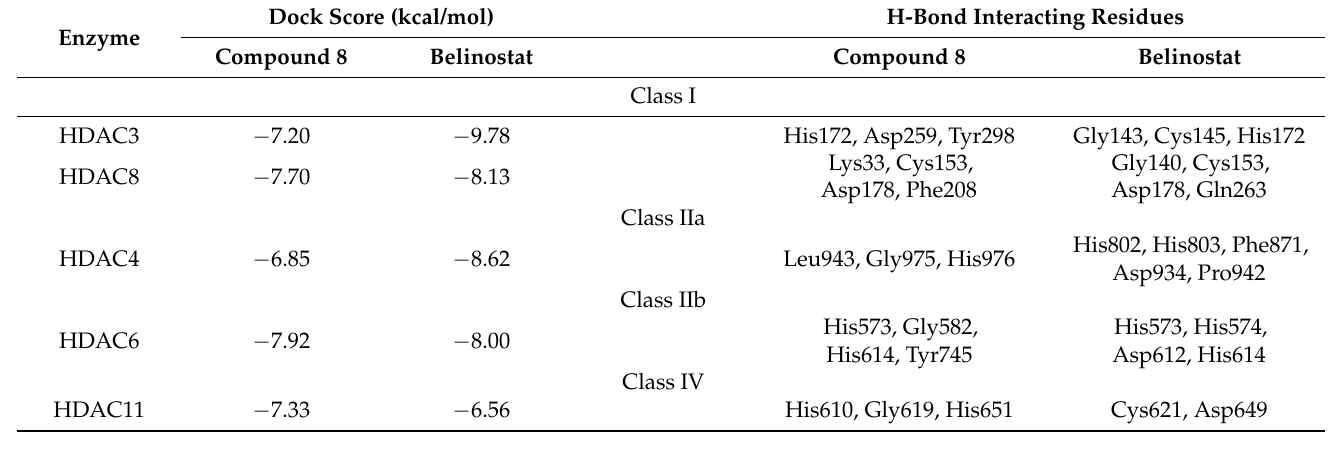
Table 3. Docking results of studied compounds and hydrogen bond interacting residues.